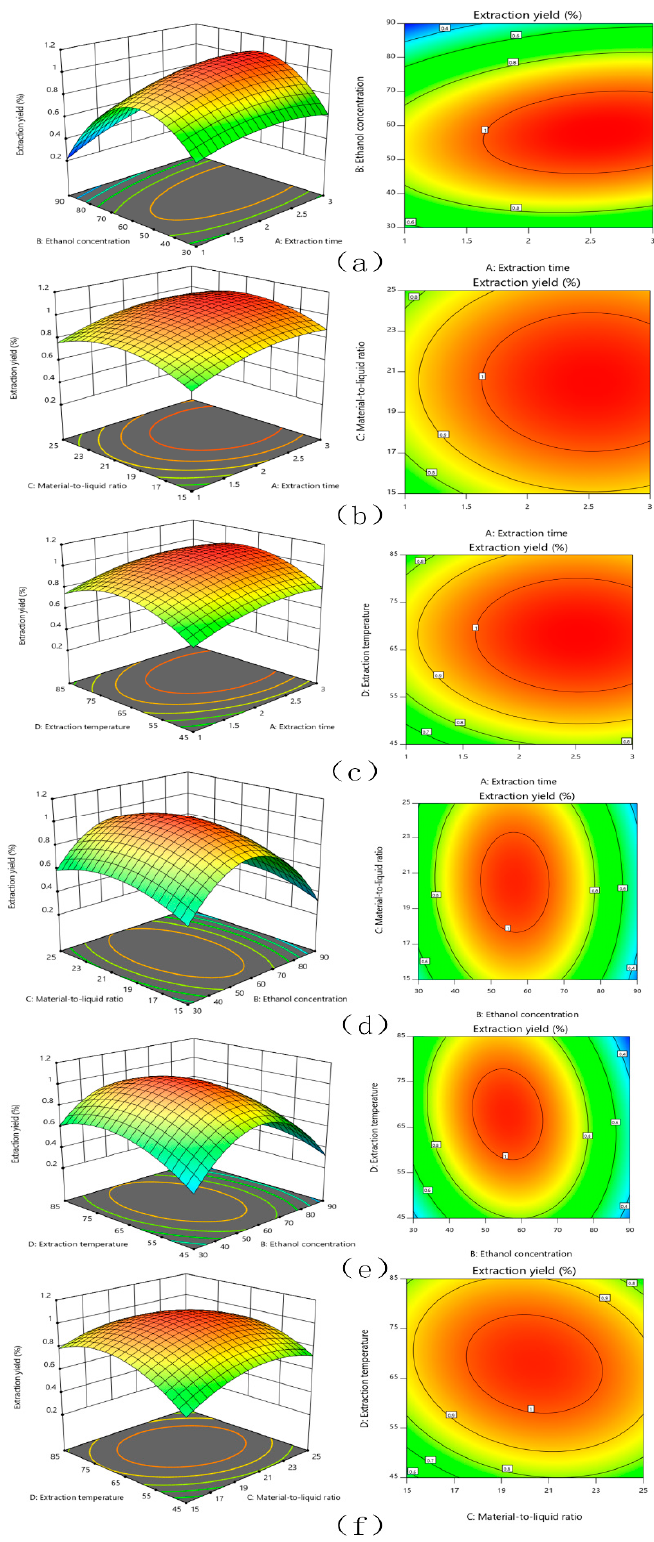
Figure 1. The mutual effects of response surface plots and contour plots for the extract yield of TFSR. ( a ) extraction time and ethanol concentration, ( b ) extraction time and material to liquid ratio, ( c ) reaction time and extraction temperature, ( d ) ethanol concentration and material to liquid ratio, ( e ) ethanol concentration and extraction temperature, ( f ) material to liquid ratio and extraction tem-